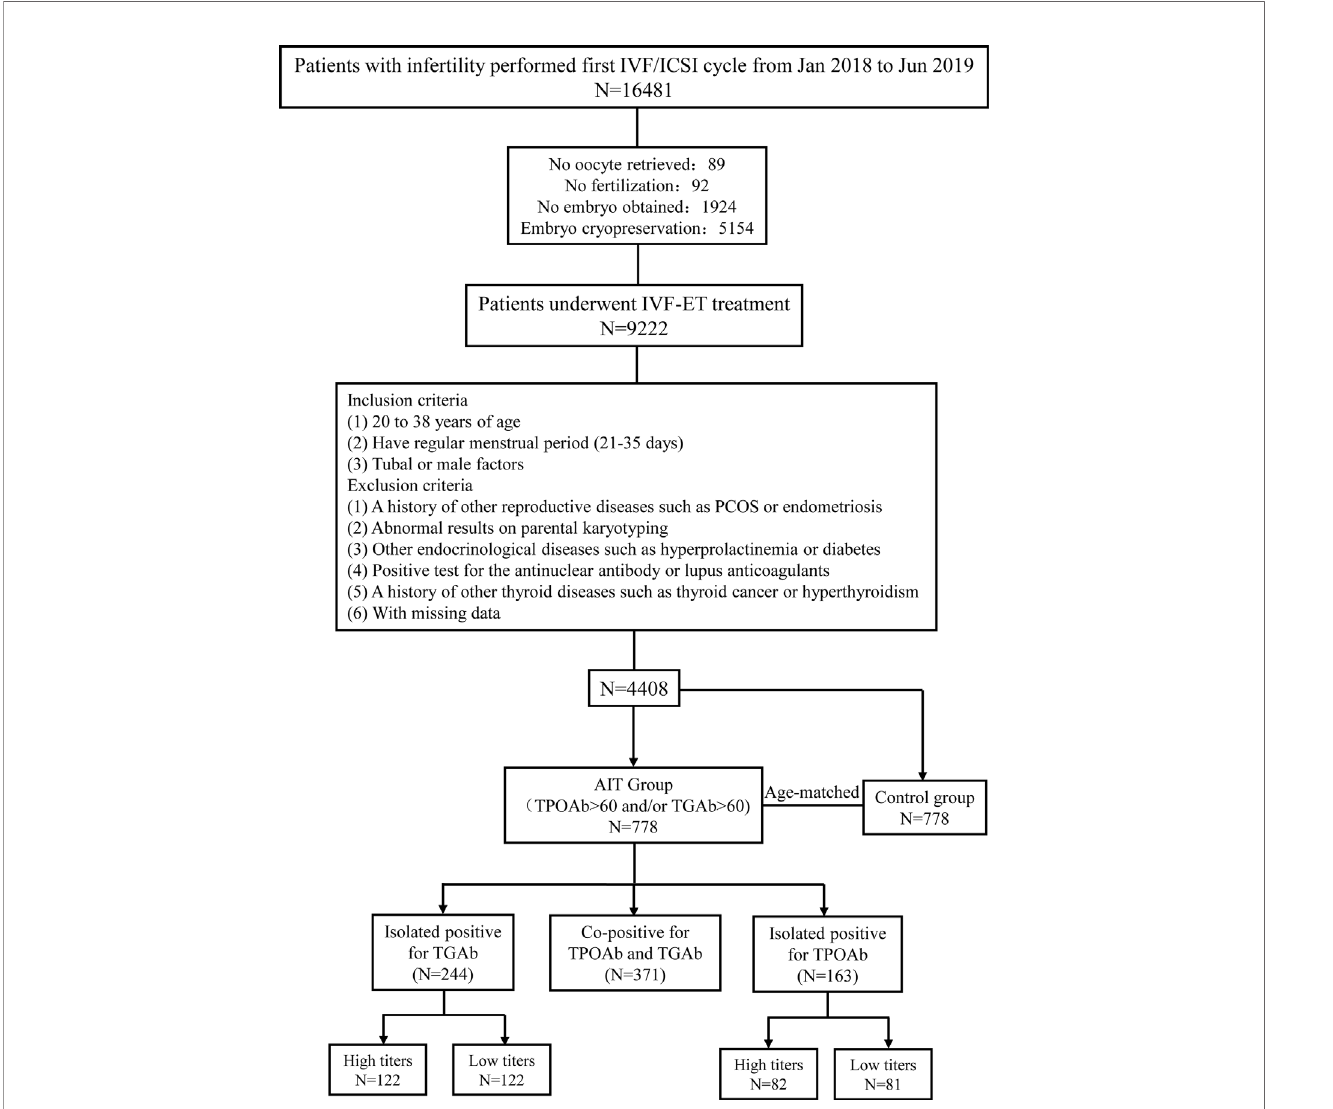
FIGURE 1 | Flow chart of study cohort selection. IVF/ICSI, in vitro fertilization/intracytoplasmic sperm injection; TGAb, thyroglobulin antibody; TPOAb, thyroid peroxidase